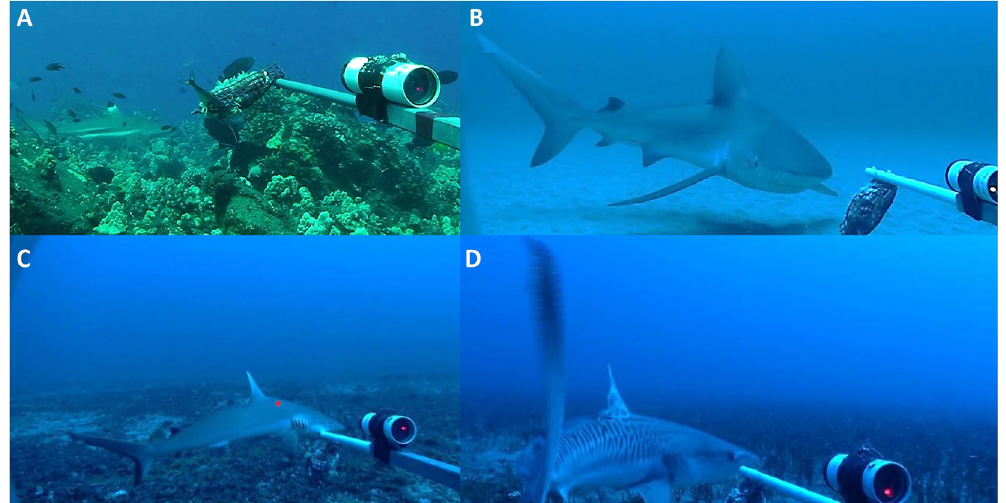
Figure 7. ( A ) Carcharhinus melanopterus , Lanai. ( B ) Carcharhinus limbatus , Oahu. Mesophotic sighting outside of 1-hour BRUVS sampling period ( C ) C archarhinus amblyrhynchos , Maui. ( D ) Juvenile Galeocerdo cuvier , Maui. BRUVS frame grab photographs by J.